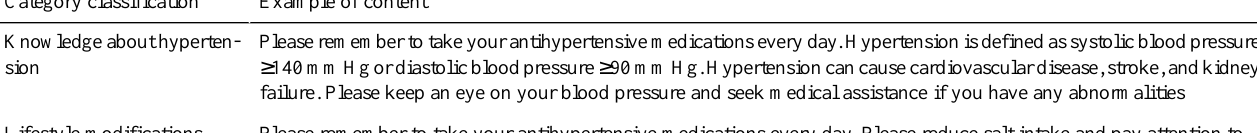
Example of contentCategory